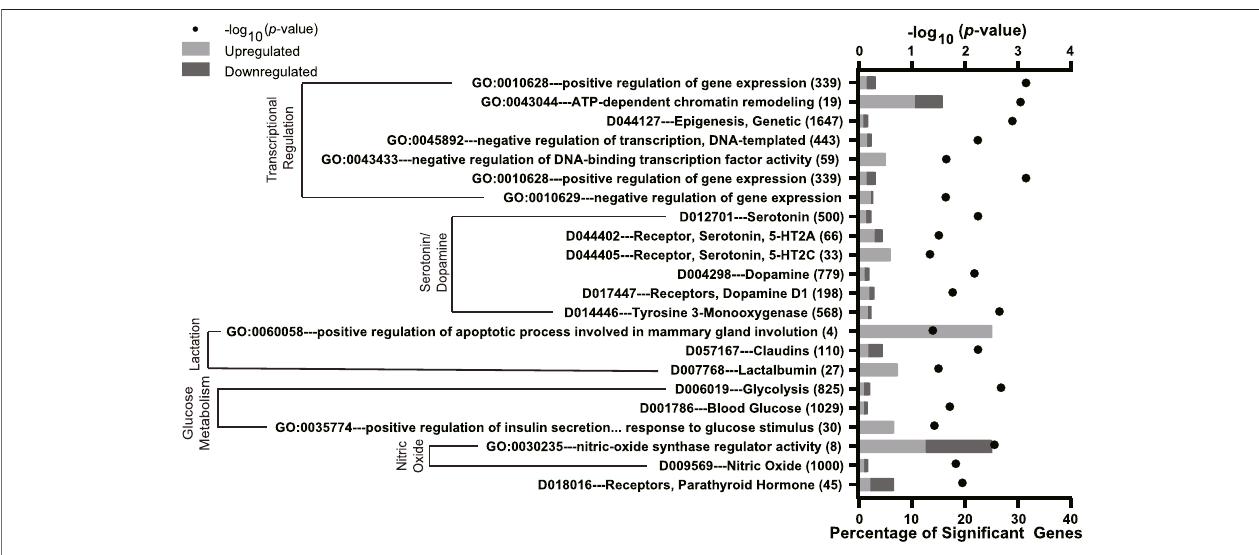
FIGURE 5 | Signi fi cantly enriched Gene Ontology (GO), Kyoto Encyclopedia of Genes and Genomes (KEGG), and Medical Subject headings (MeSH) pathways in themammaryglandofmicewithfolicacid(FA)supplementation(24 mg/kgFAindiet)orbreederdiet(4 mg/kgFAindiet)for5±2 weeks.They-axis denotes thenames and totalnumber ofgenes ineach pathway, and thelower x-axis denotes thepercentage ofsigni fi cantgenes within each pathway. The upper x-axis denotes the − log 10 p -value. Light gray bars indicate upregulated DEGs and dark gray bars indicate downregulated DEGs within each pathway.